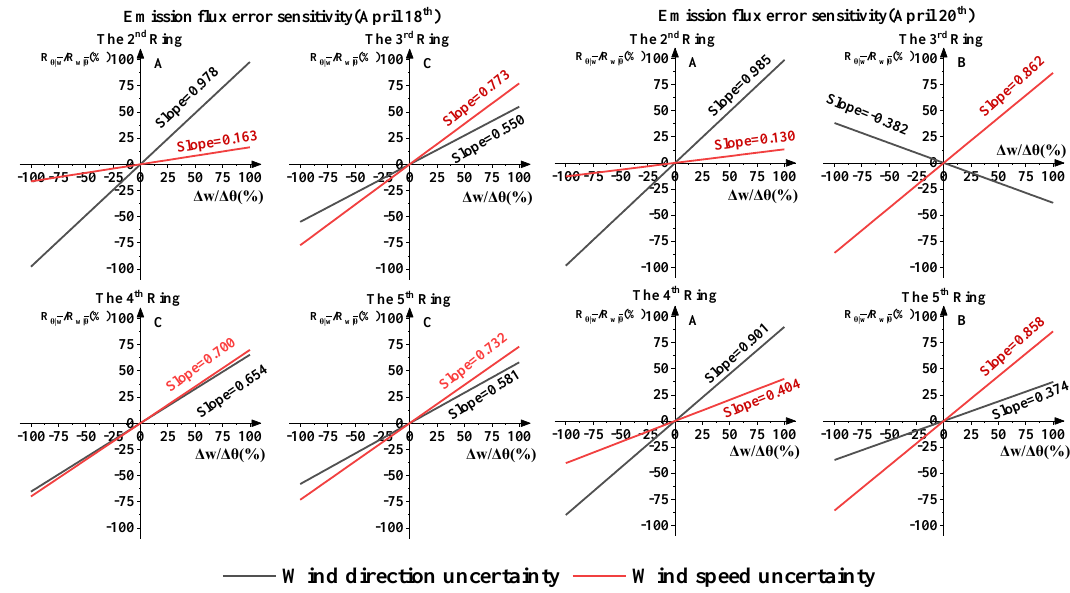
Figure 10. The emission flux error change rate ( r θ | w / r rate ( ∆ θ / ∆ w ) on April 18th and 20th. The higher the slope, the more sensitive it is to the NO X emission flux